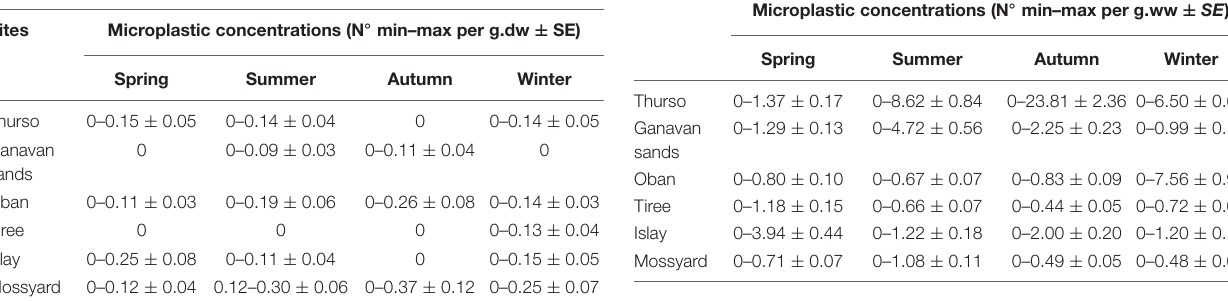
TABLE 3 | Minimum and maximum concentrations of microplastics in sediment (number of particles per g of dry weight) with the standard errors for each site and season.